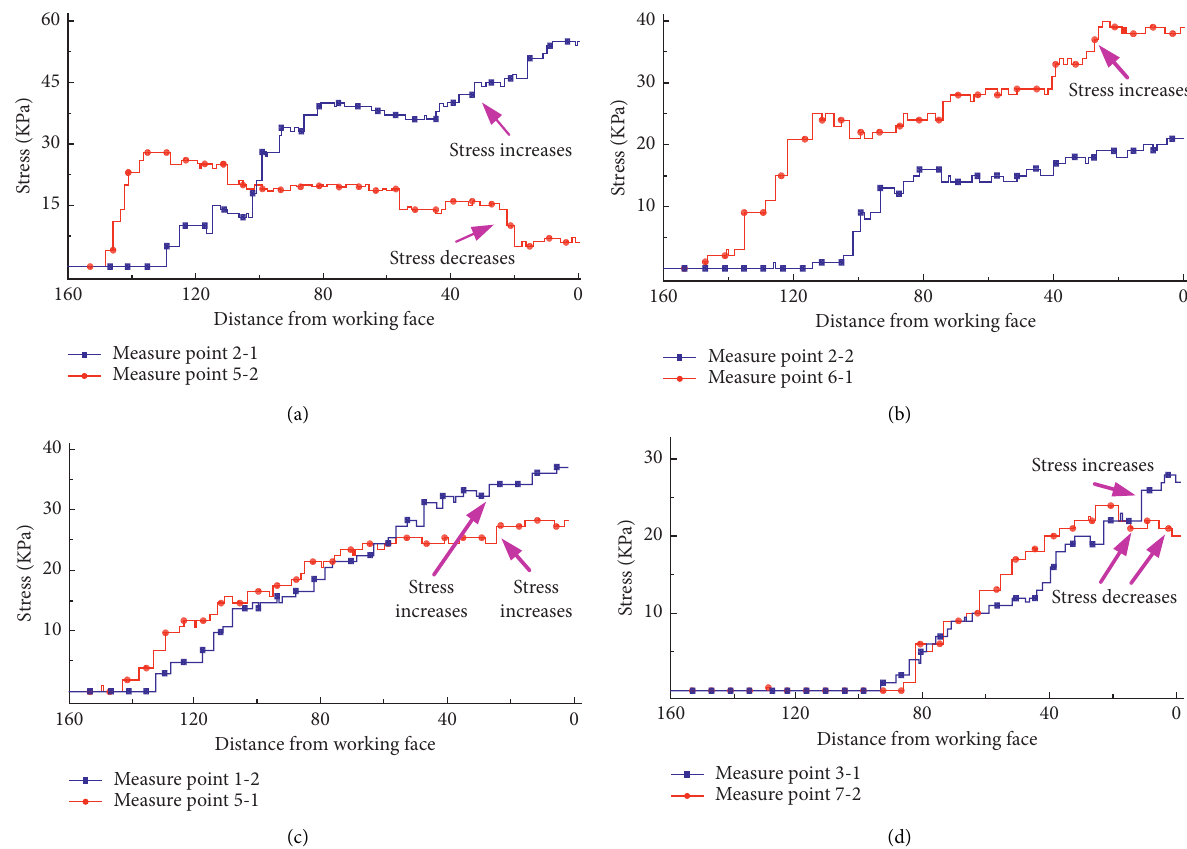
Figure 7: Stress evolution contrast analysis diagram of different measuring points. (a) Stress evolution curves of measuring points 2-1 and 5- 2. (b) Stress evolution curve of measuring points 2-2 and 6-1. (c) Stress evolution curve of measuring point 1-2 and 5-1. (d) Stress evolution curve of measuring points 3-1 and